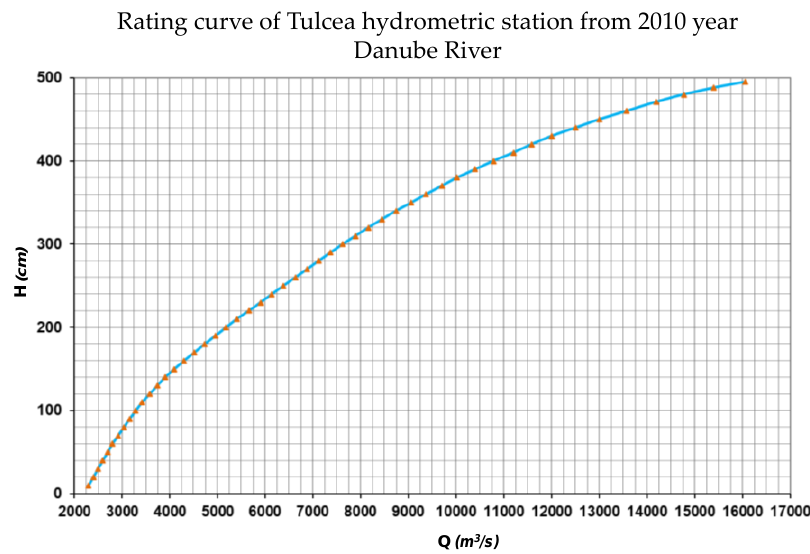
Figure A5. Rating curve values at the Tulcea gauge station during the 2010 flood year.